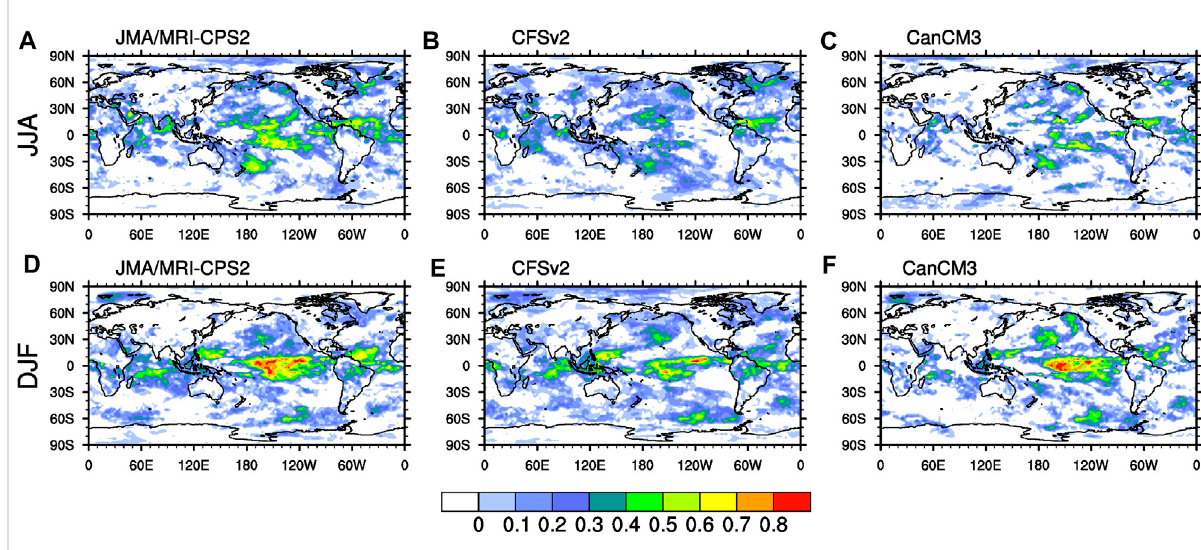
FIGURE 3 Spatial distributions of Ranked Probability Skill Scores (RPSS) for JMA/MRI-CPS2 (A,D) , CFSv2 (B,E) and CanCM3 (C,F) of temperature in JJA (A – C) and DJF (D – F) season for the period 1982 –